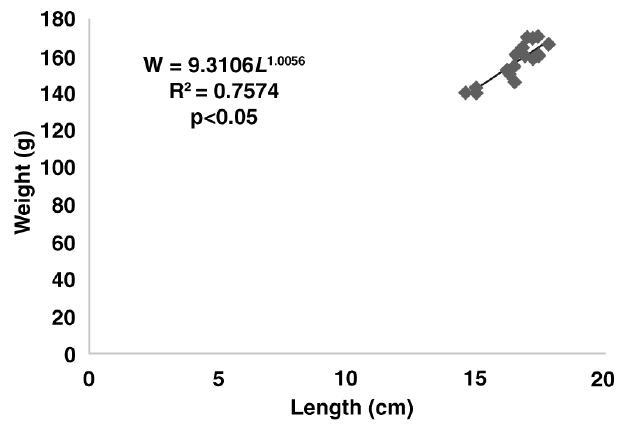
Figure 3. Total length-weight relationship for gurami sago cultured in concrete ponds. Each point represents one sampled fish ( N =24). The regression equation, coefficient of determination (R 2 ) and significance ( p -values) are also provided.